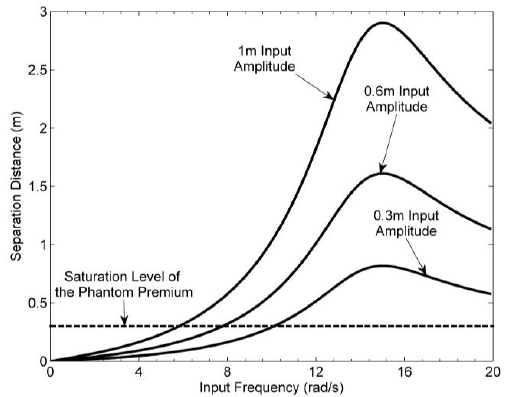
Figure 4. The variation of the largest separation distance between commanded position and servomechanism for a range of input frequencies at input amplitudes of 0.3, 0.6 and 1.0 m showing the limitations that device saturation places on the upper frequency limit of the device.